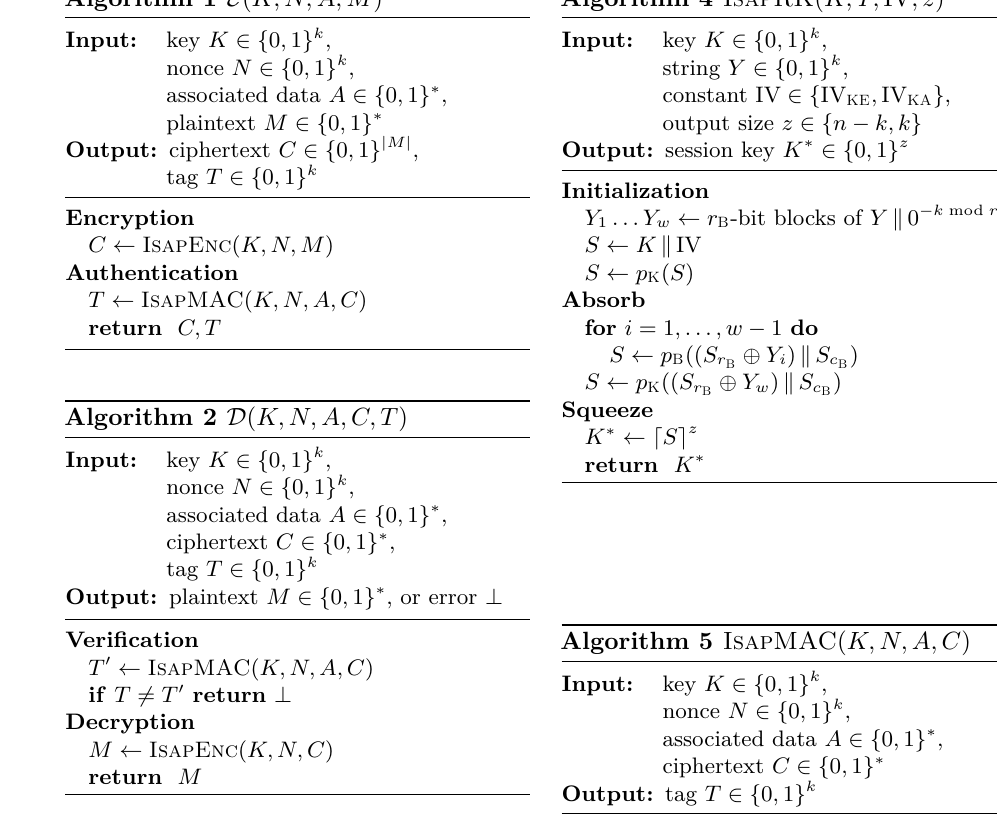
Algorithm 3 IsapEnc ( K, N, M )